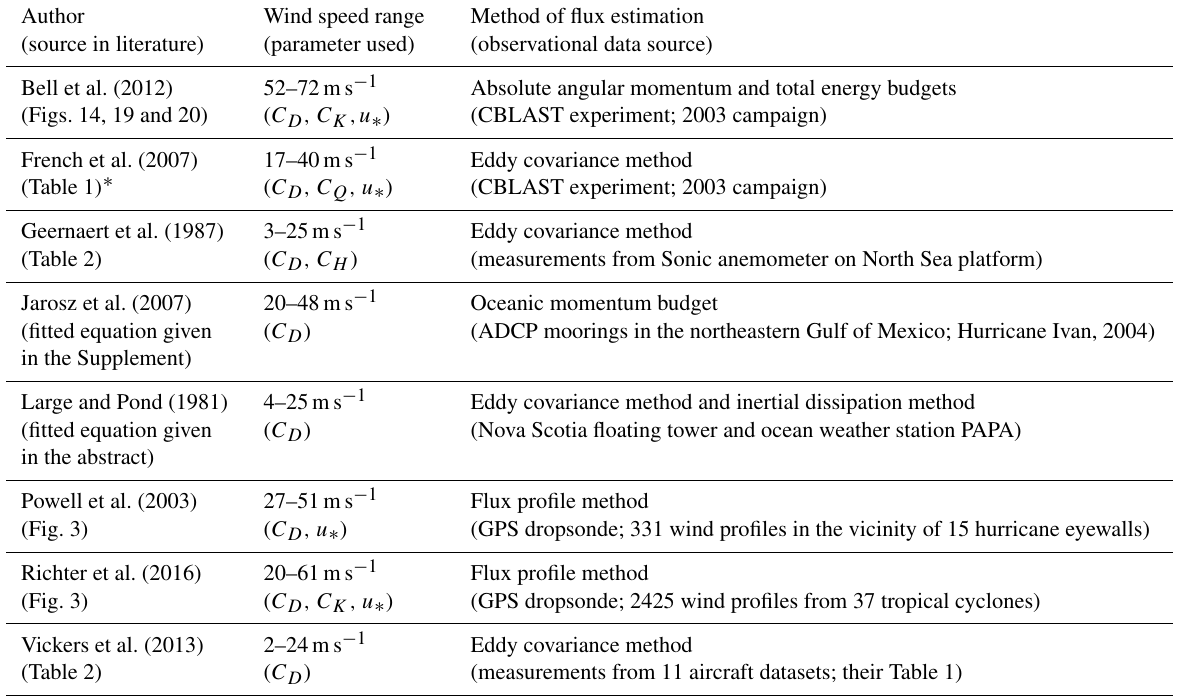
∗ The values of C Q were obtained from Table 1 of French et al. (2007), whereas the corresponding data analyses were reported by Drennan et al.